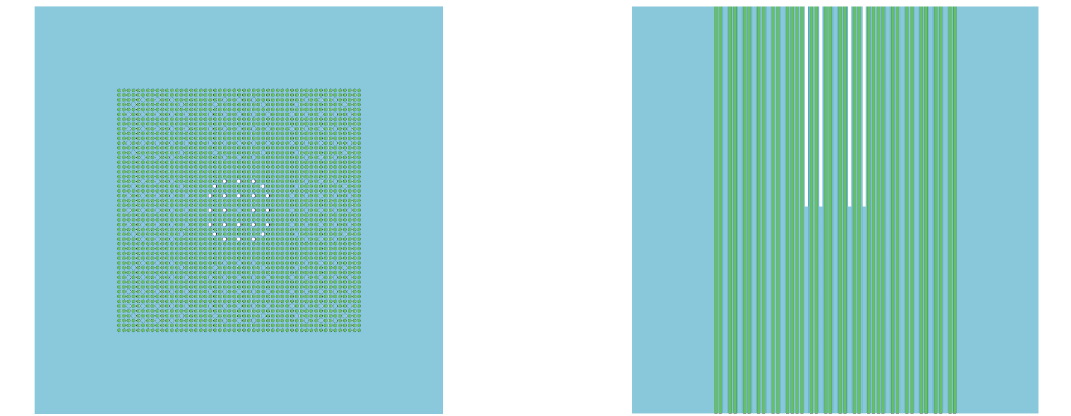
Figure 1: Radial (left) and axial (right) cuts of the PWR mini-core model used in the test